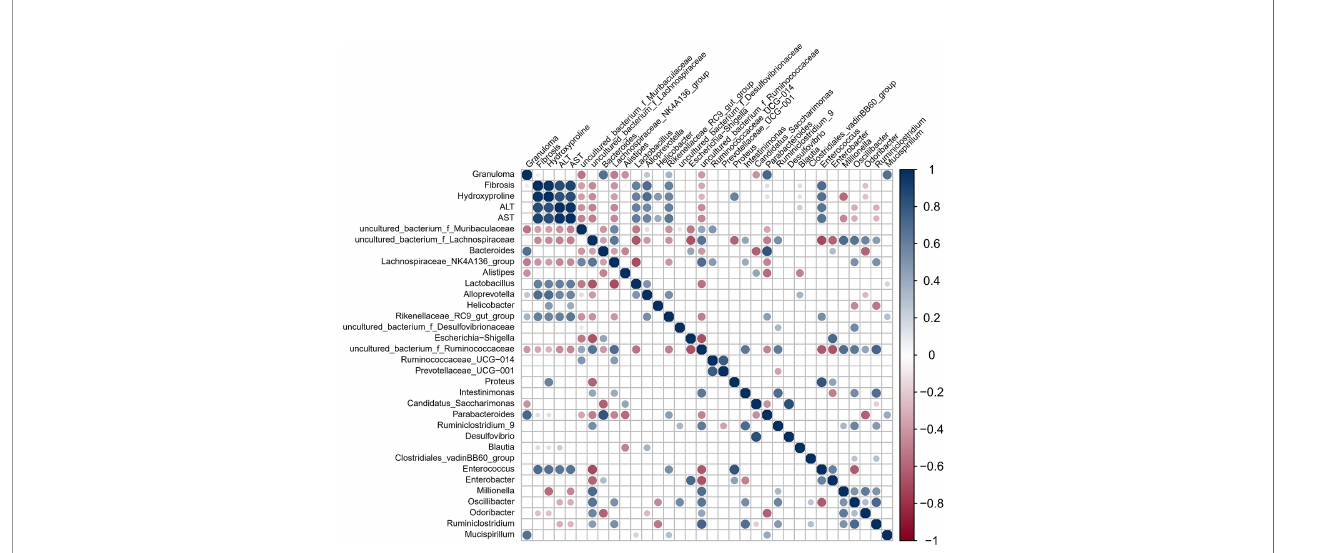
FIGURE 3 | Spearman correlation for variables in S. japonicum- infected mice was shown. The circle size indicates the magnitude of the correlation. The circle in color indicates P <0.05, P < 0.01 or P < 0.001.